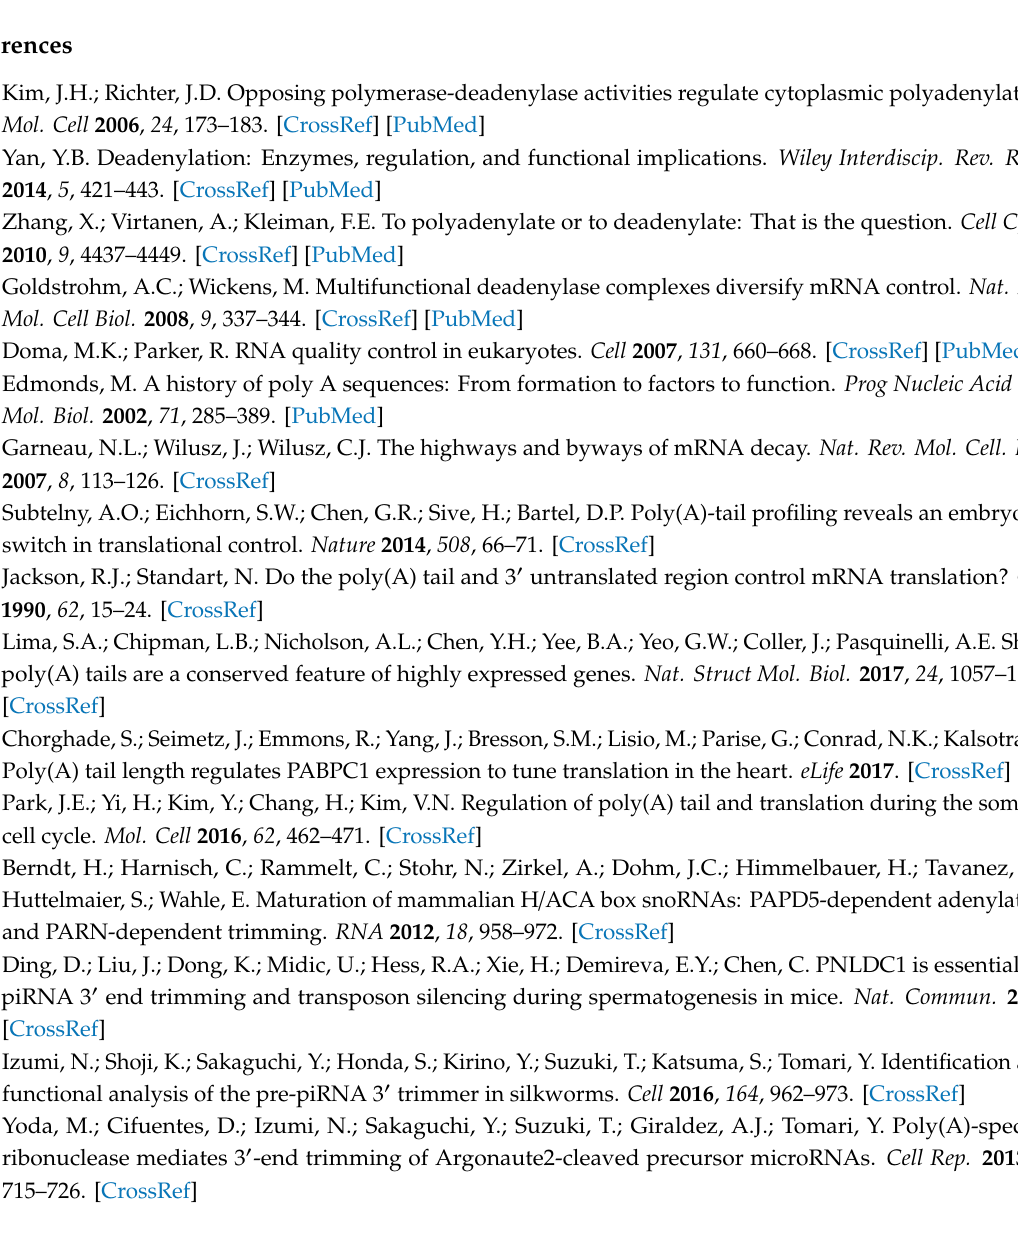
Figure S1: E ff ect of temperature, pH and K + on PARN-CTD structural features monitored by far-UV CD and Trp fluorescence excited at 295 nm, Figure S2: K + enhanced PARN-CTD Trp fluorescence in a concentration-dependent manner, implying that there is specific binding of K + with PARN-CTD, Figure S3: Sequence alignment of the predicted NLS and NoLS, Figure S4: Representative profiles of flow cytometry analysis of cell apoptosis determined by Annexin V-FITC binding (horizontal) and PI exclusion (vertical), Figure S5: Western blot analysis of the protein levels of CstF-50 and p53 in untreated or UV-treated HEK-293T cells transfected with plasmids containing the full length or truncated